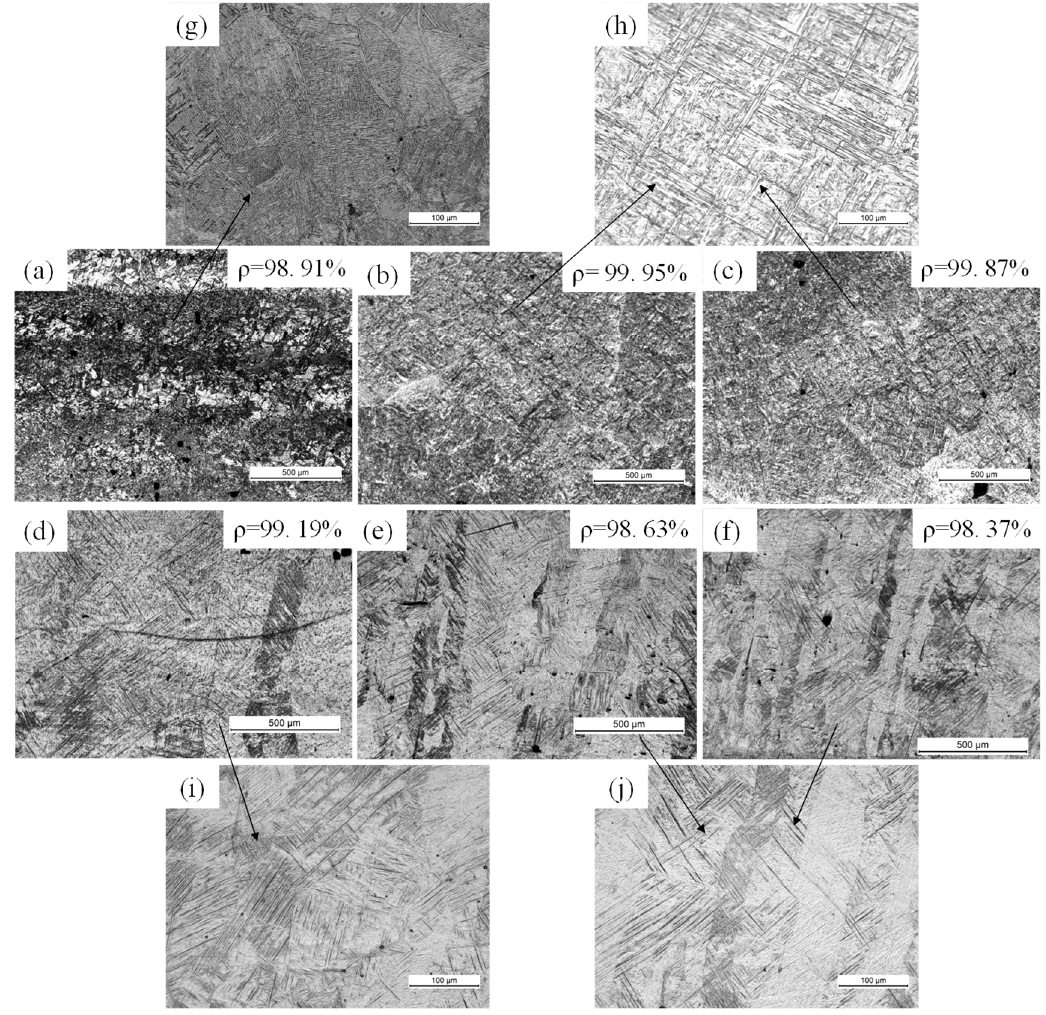
Figure 10. Microstructure and density of SLM Ti-6Al-4V samples made at different scanning speeds and hatch spacings using the 200-µm-diameter laser beam. ( a ) v = 25 mm/s; ( b ) v = 50 mm/s; ( c ) v = 75 mm/s; ( d ) v = 100 mm/s; ( e ) v = 125 mm/s; ( f ) v = 150 mm/s. High-magnification optical micrographs showing the ( g ) Widmanstätten and ( h , j ) martensite microstructures.